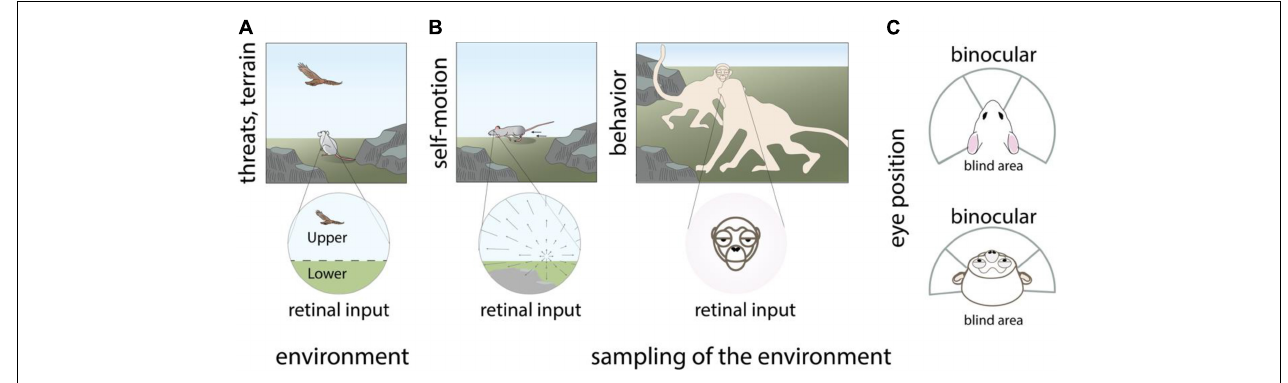
FIGURE 1 | Visual inputs received by the retina exhibit location-dependent statistics. Topographic variations in visual inputs to the retina are species-specific and arise from (A) non-uniform statistics of the visual environment such as predators that appear overhead, (B) Non-uniform behavioral sampling of the visual environment as produced by self-motion of the eyes, head, and body, as well as other behaviors including social communication, (C) the position of the eyes in the head and resulting extent of the binocular visual field. Panels (A,B) modified with permission from © 2021 Dina Popovkina.